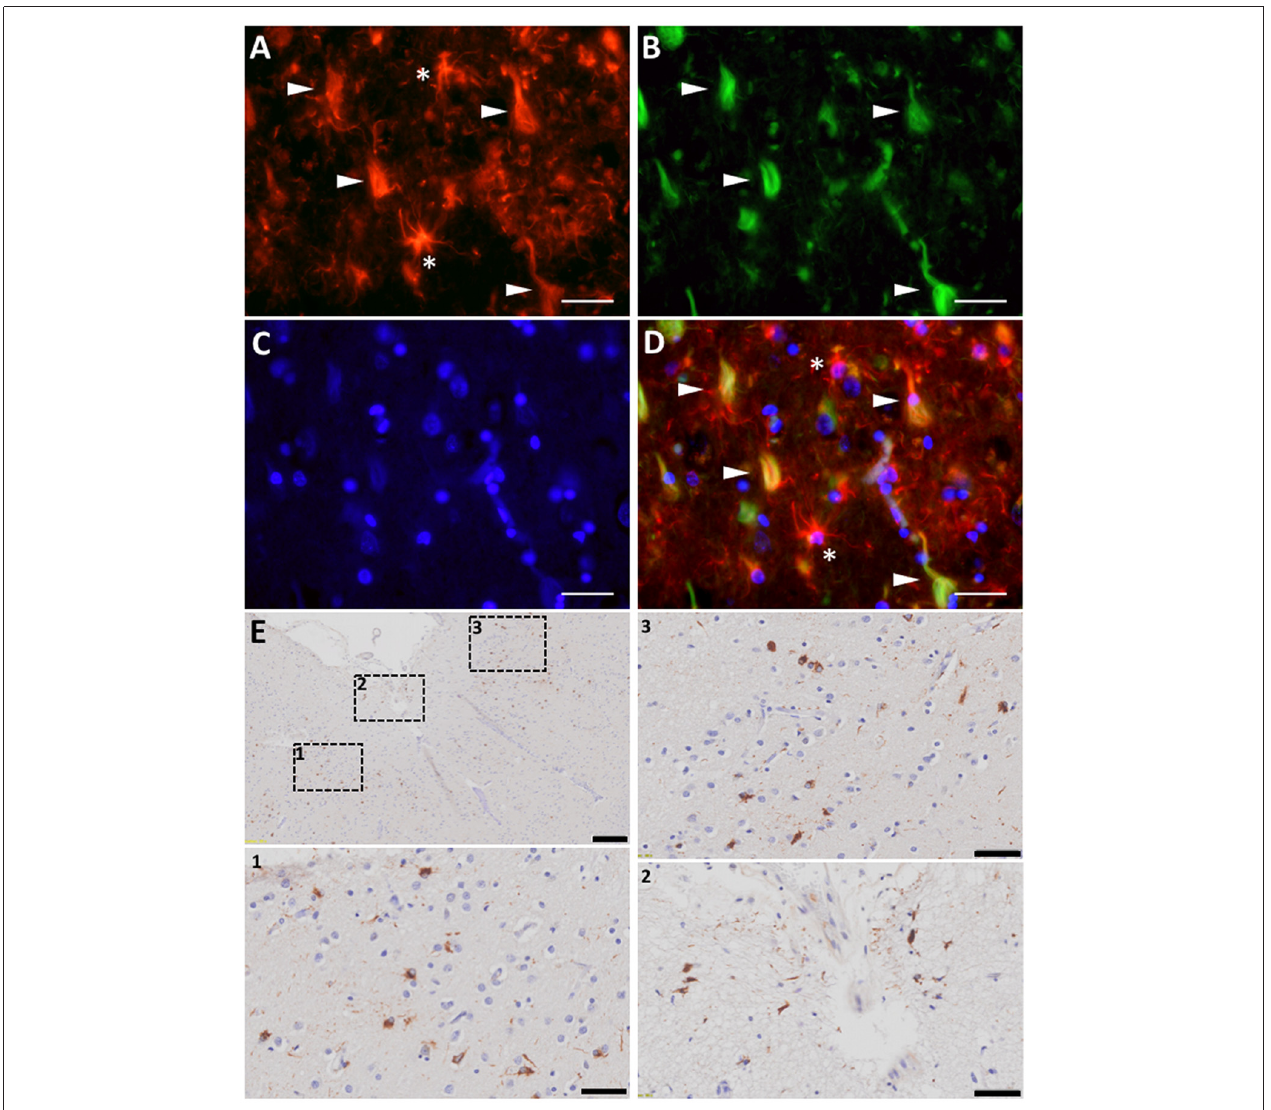
FIGURE 4 | Astrocyte reaction to neurofibrillary tangles (NFTs) in the Alzheimer’s brain. (A–D) Fluorescent immunohistochemical staining for GFAP ( A , red) with Thioflavine-S ( B , green) and DAPI ( C , blue) staining in the temporal association neocortex (Brodmann’s Area 38) of an individual with a diagnosis of AD. Reactive (GFAP+) astrocytes surround and penetrate extracellular “ghost” NFTs, so that these late-stage extracellular NFTs become GFAP-immunoreactive ( D , merge). (E) Peroxidase-DAB immunohistochemical staining for total tau showing thorn-shaped tau-immunoreactive astrocytes in the subpial (inset 2) and mid layers (insets 1 and 3) of the frontal association cortex (Brodmann’s areas 8/9) of a subject with a diagnosis with AD. Scale bars: 10 µ m in (A–D) , 200 µ m in (E) , and 50 µ m in insets